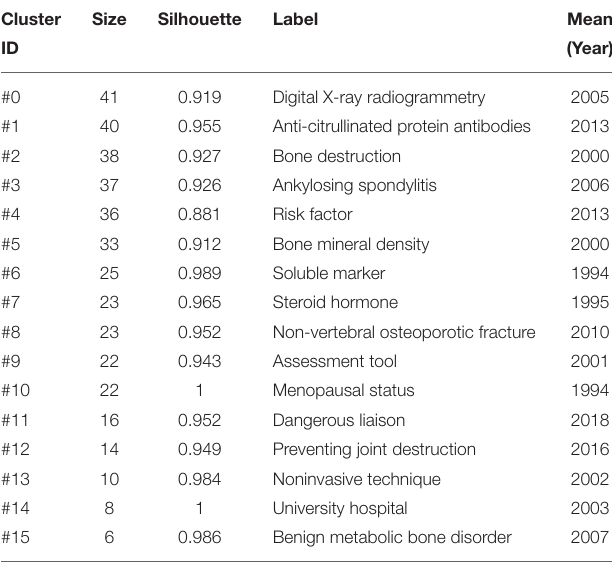
TABLE 4 | The clusters information of co-cited